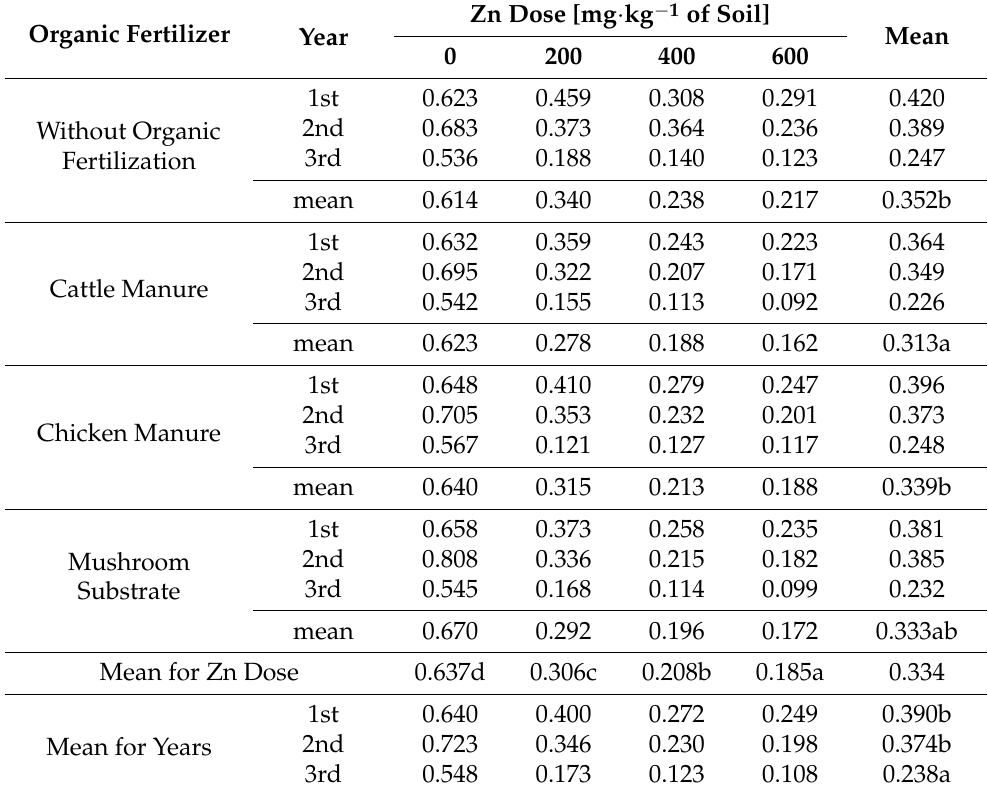
Table 8. Zinc bioaccumulation factor in